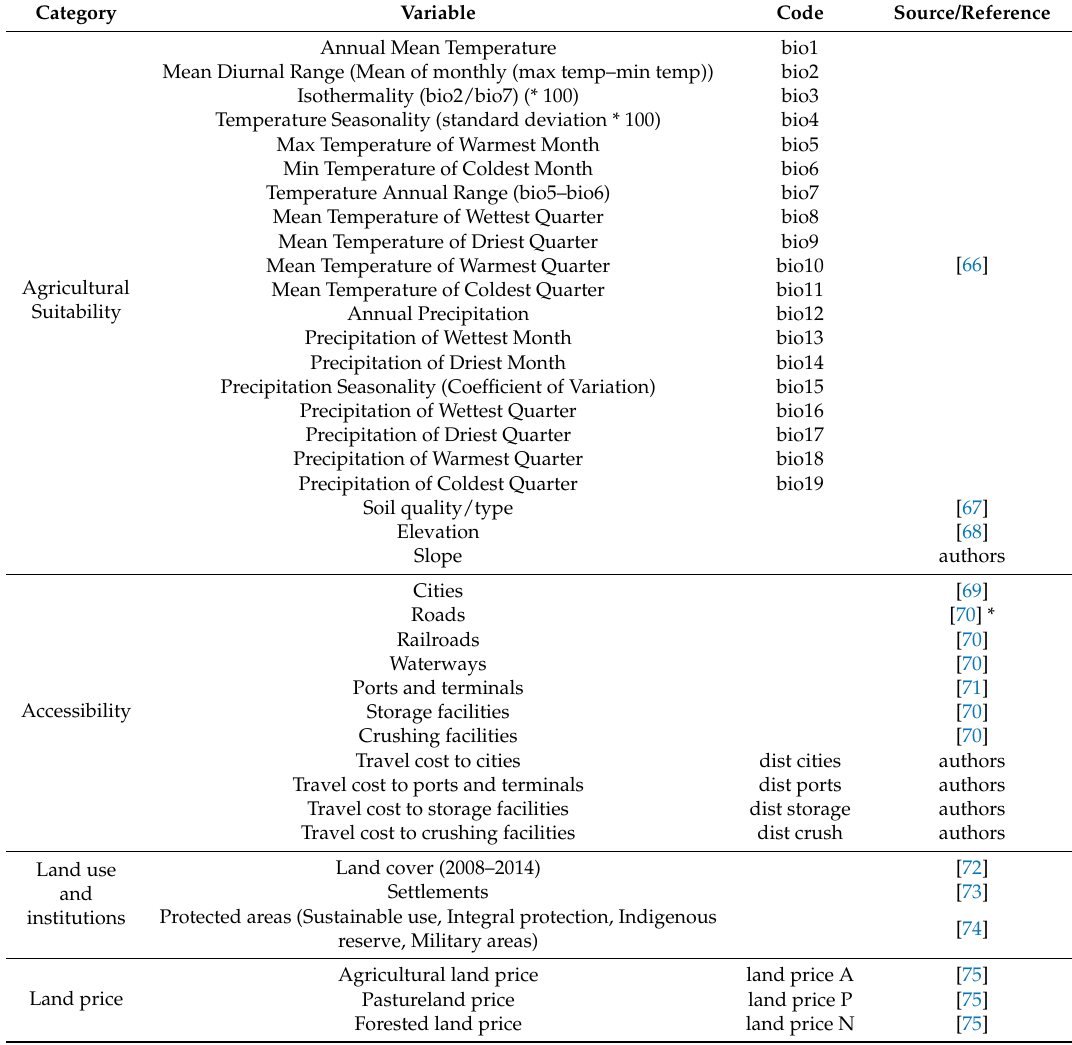
Table 1. Summary of model input